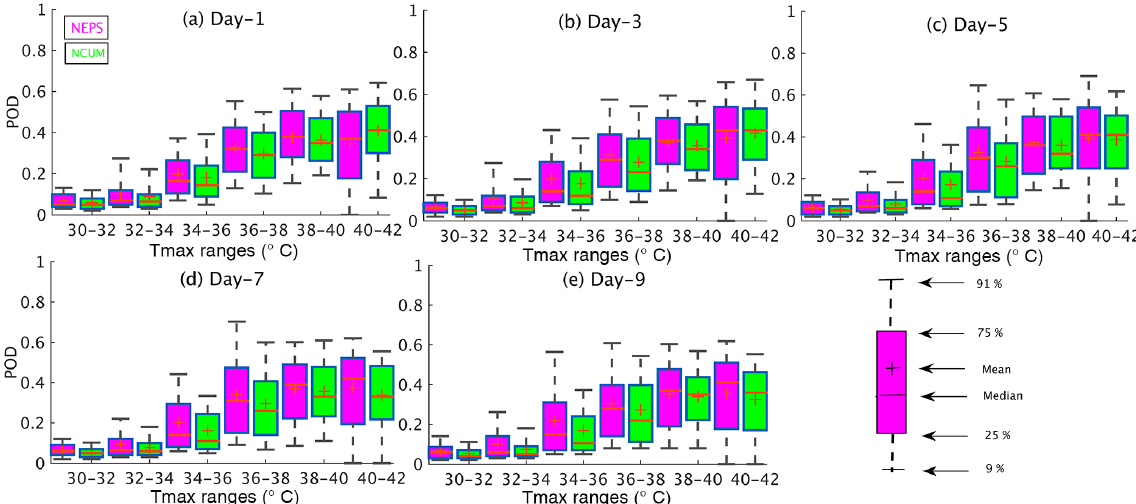
Figure 12. Box plots (a–e) for probability of detection (POD) for NCUM and NEPS from March to May 2016 (NCUM stands for NCMRWF unified model and NEPS stands for NCMRWF ensemble prediction system). POD values are higher in NEPS forecasts, particularly at high temperature ranges (>36 ◦ C), and for all lead times compared to NCUM forecasts, suggesting improved performance of NEPS at higher temperature ranges.